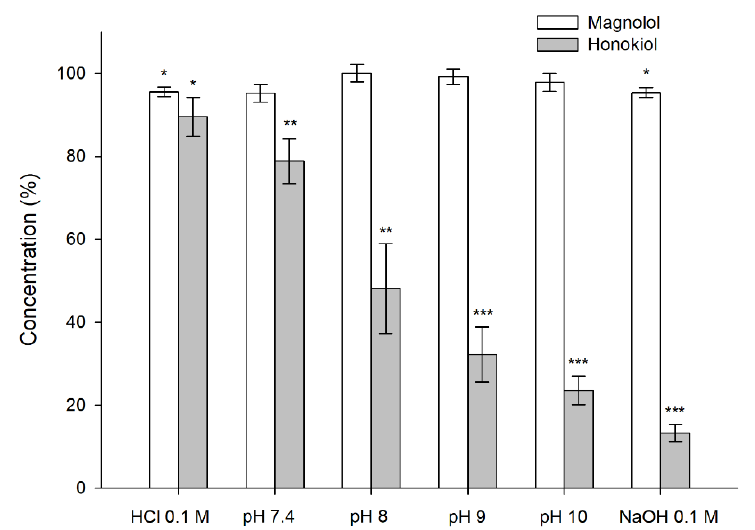
Figure 4. Stability of magnolol and honokiol in 0.1 N HCl, 0.1 N NaOH, and different pH buffers after 24 h at 60 °C. Data are expressed as the percentage of the initial concentration. * p < 0.05, ** p < 0.01, *** p < 0.001.